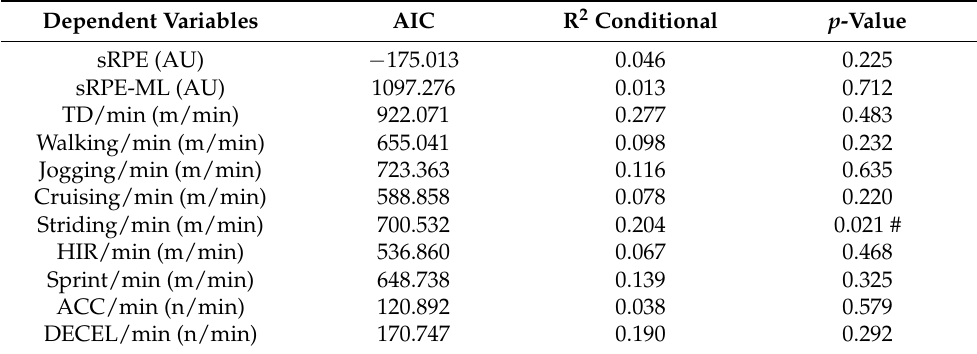
Table 1. Match-to-match differences in match load measures.